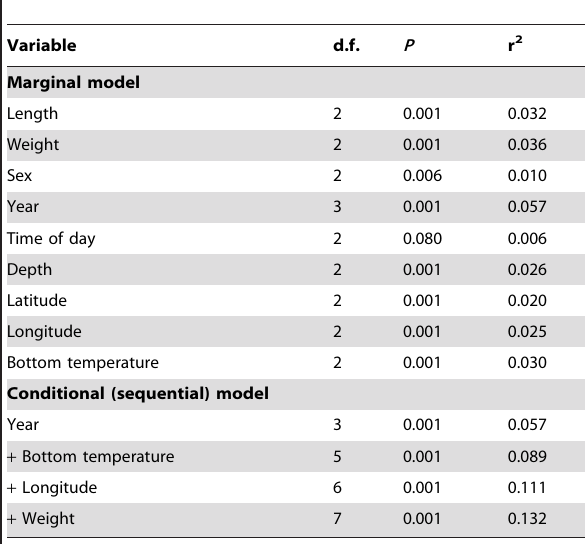
Table 1. Squalus acanthias results of the DistLM analysis marginal and conditional tests, using all stomachs containing prey ( n